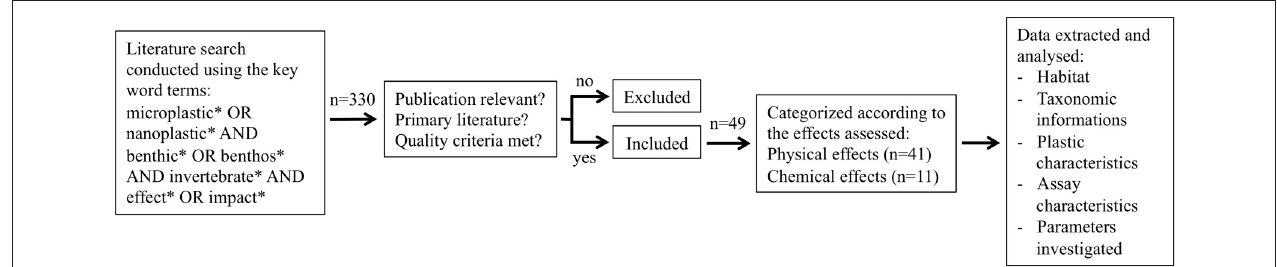
FIGURE 1 | Schematic representation of the review process, publication selection and data